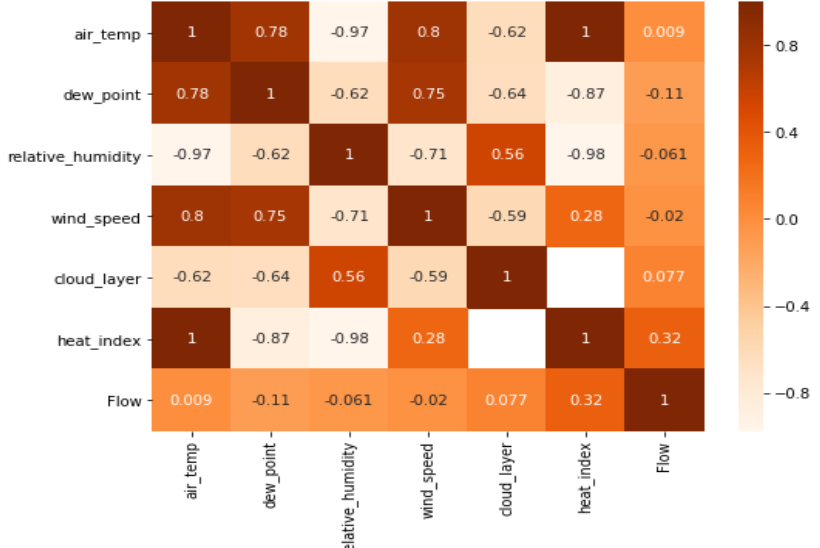
Figure 6. Heatmap of traffic flow and weather